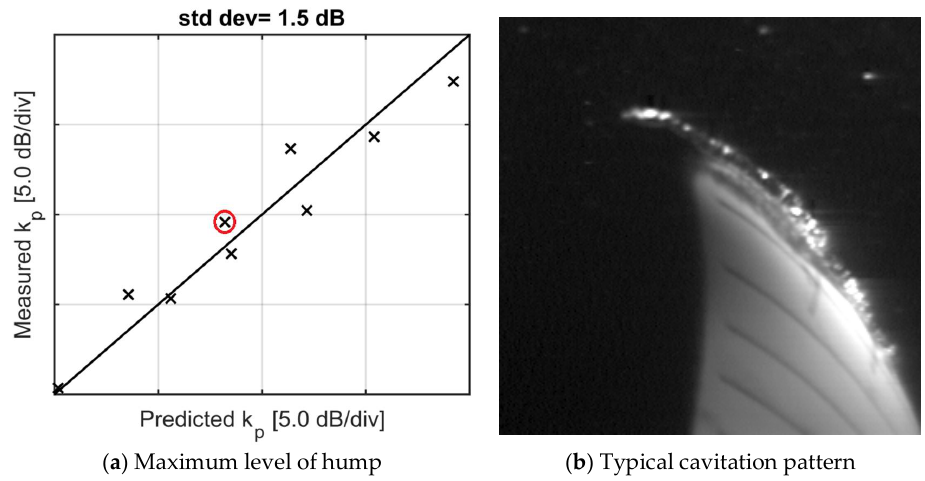
Figure 8. Comparison between measured and predicted maximum level of the hump for a two-bladed research propeller tested at various advance ratios and cavitation numbers. The cavitation pattern corresponding to the encircled symbol is shown on the right.